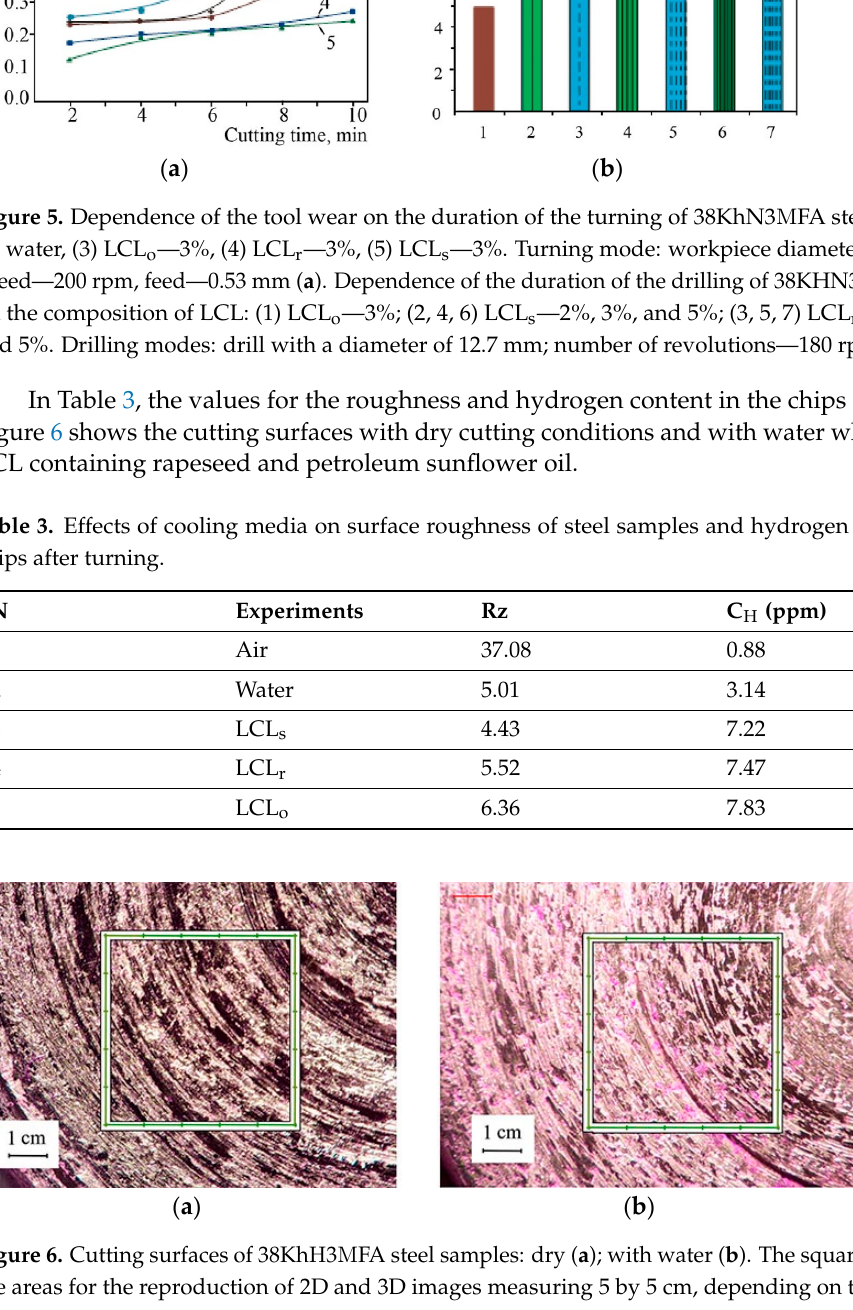
Figure 5. Dependence of the tool wear on the duration of the turning of 38KhN3 М F А steel: (1) dry,